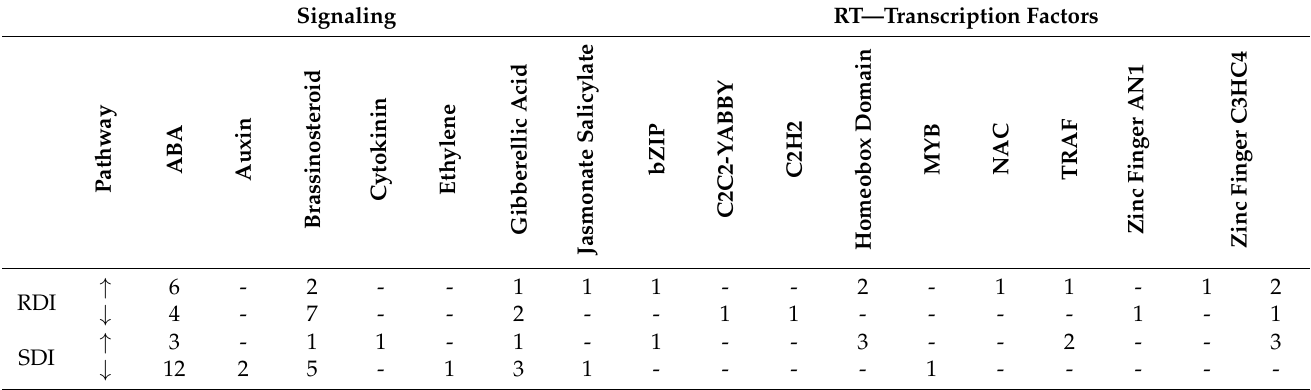
Table 3. Detailed analysis of the transcripts up- ( ↑ ) and downregulated ( ↓ ) in the functional categories signaling and RT—transcription factors, according to the results shown in Figure 4. “Pathway” in signaling is represented by calcium sensors and signaling, protein kinases, protein phosphatases, and signaling molecules. Signaling RT—Transcription